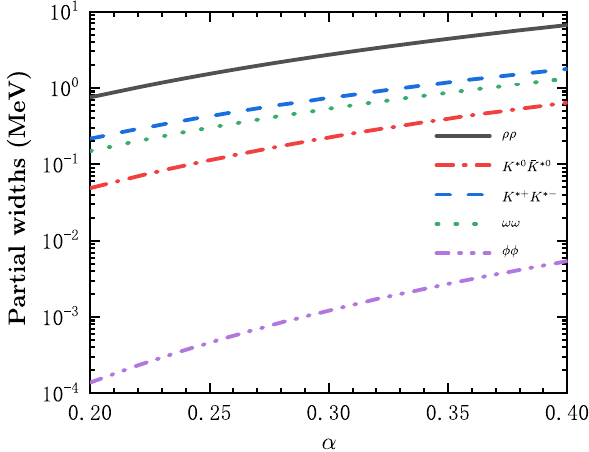
→ V V with the c 1